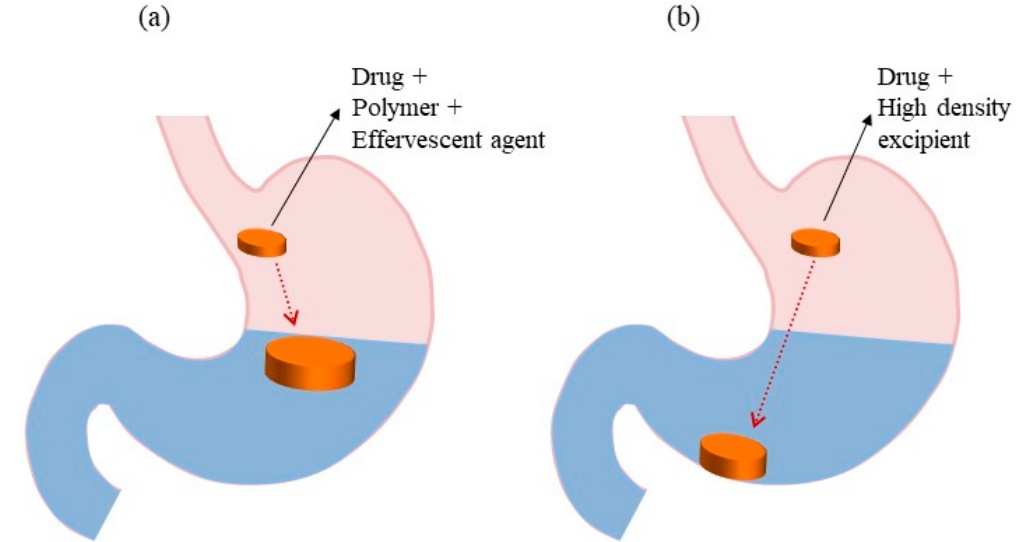
Figure 2. GRDDS based on ( a ) low-density systems and ( b ) high-density systems.